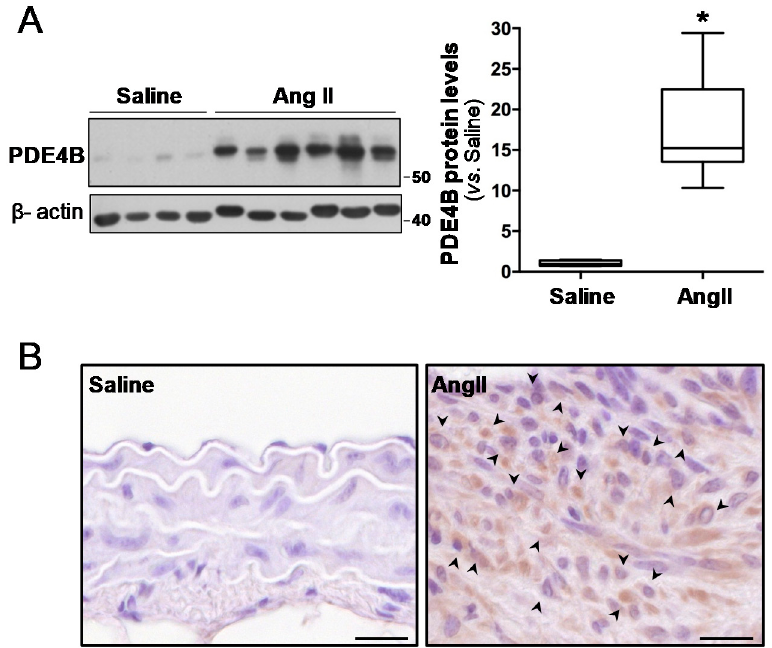
Figure 1. PDE4B expression is up-regulated in the abdominal aortas from AngII-infused ApoE − / − mice. ApoE − / − mice were infused with AngII (1000 ng/kg/min) or saline solution for 28 days. ( A ) The PDE4B expression in abdominal aortas from these animals was assessed by Western blot. The levels of β -actin are shown as a loading control. The boxplot on the right shows the quantification of the PDE4B protein levels. The box extends from the 25th to the 75th percentile, and the median is indicated by a horizontal line. The whiskers represent the maximum and minimum values (Saline, n = 4; Ang II n = 6); * p < 0.01 vs. saline. ( B ) Representative PDE4B immunostaining in these samples. The arrowheads indicate the PD4B-positive cells in aneurysmal tissues. Bars: 20 µm.